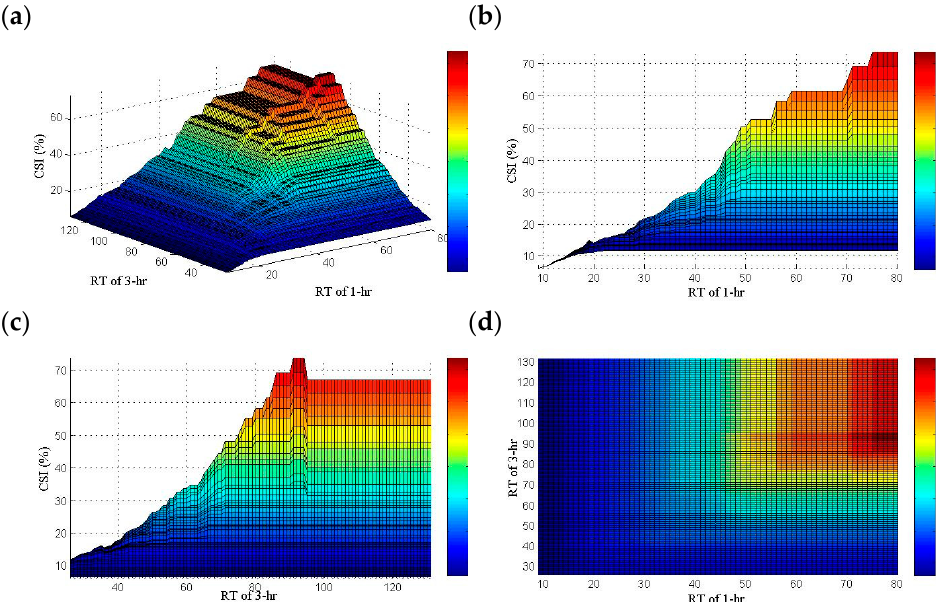
Figure 10. The CSI results at the Gongguan (C1A730) rain gauge in the Daan district: ( a ) the rainfall thresholds with 1-h and 3-h durations with constant values of ORTs with 6-, 12- and 24-h durations; ( b ) the rainfall threshold with 1-h duration; ( c ) the rainfall threshold with 3-h duration; ( d ) the rainfall threshold with 1-h and 3-h durations.